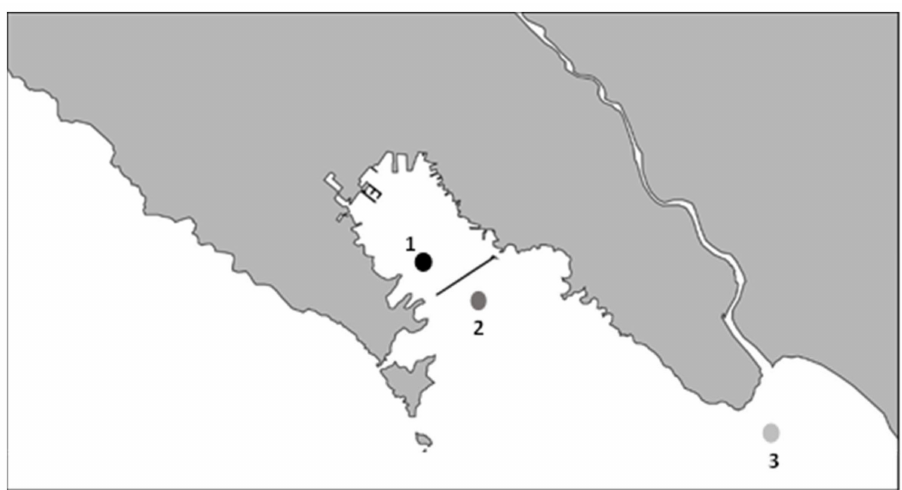
Figure 1. Schematic map of sampling sites: (1) Main production area, (2) relaying site 2, (3) relaying site 3. The approximate distance from (1) to (2) is 0.94 Km, and (1) to (3) is 11.5